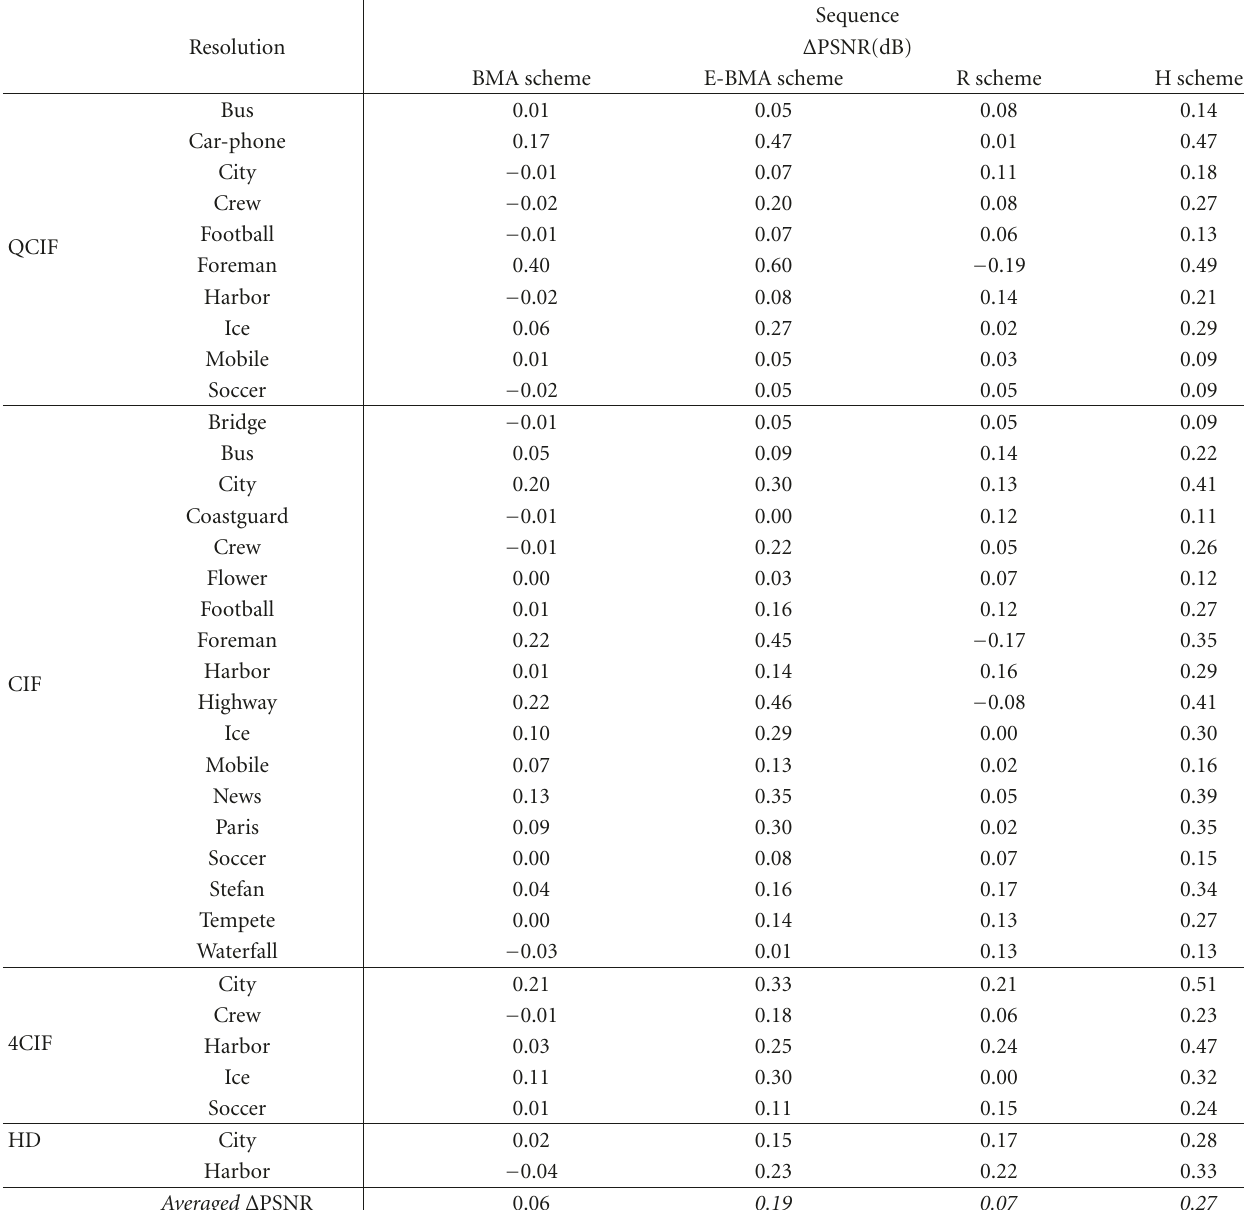
Table 4: Video quality assessment of BMA scheme, E-BMA scheme, R scheme, and H